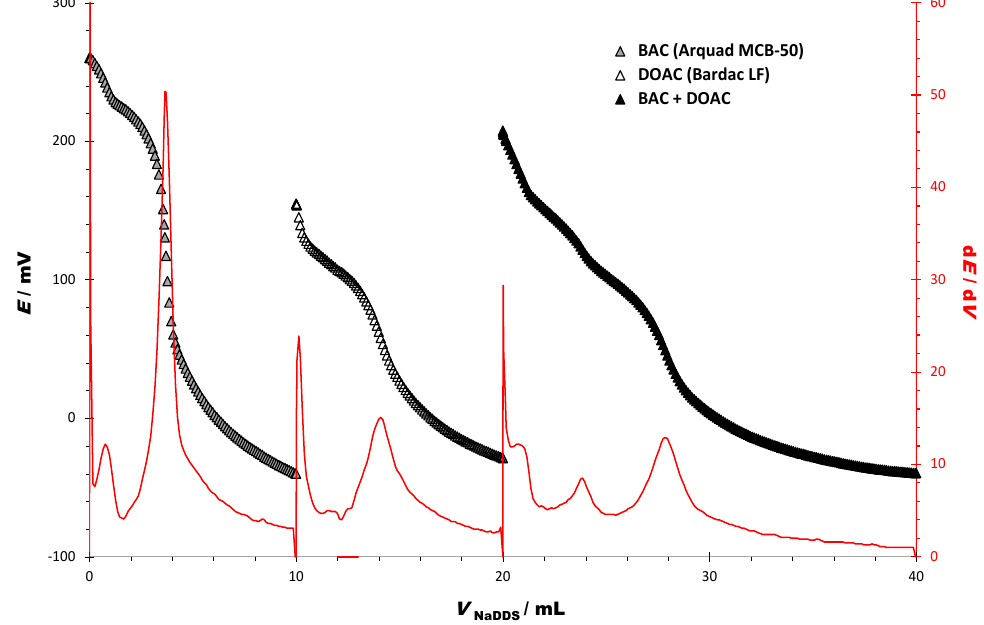
Figure 3. Potentiometric titration curves and their first derivatives of BAC, DOAC, and the two- component model mixtures of BAC and DOAC (1:1 w / w ), using DDS as titrant ( c = 4 × 10 −3 mol/L) and DODI - TPB potentiometric sensor as an indicator.